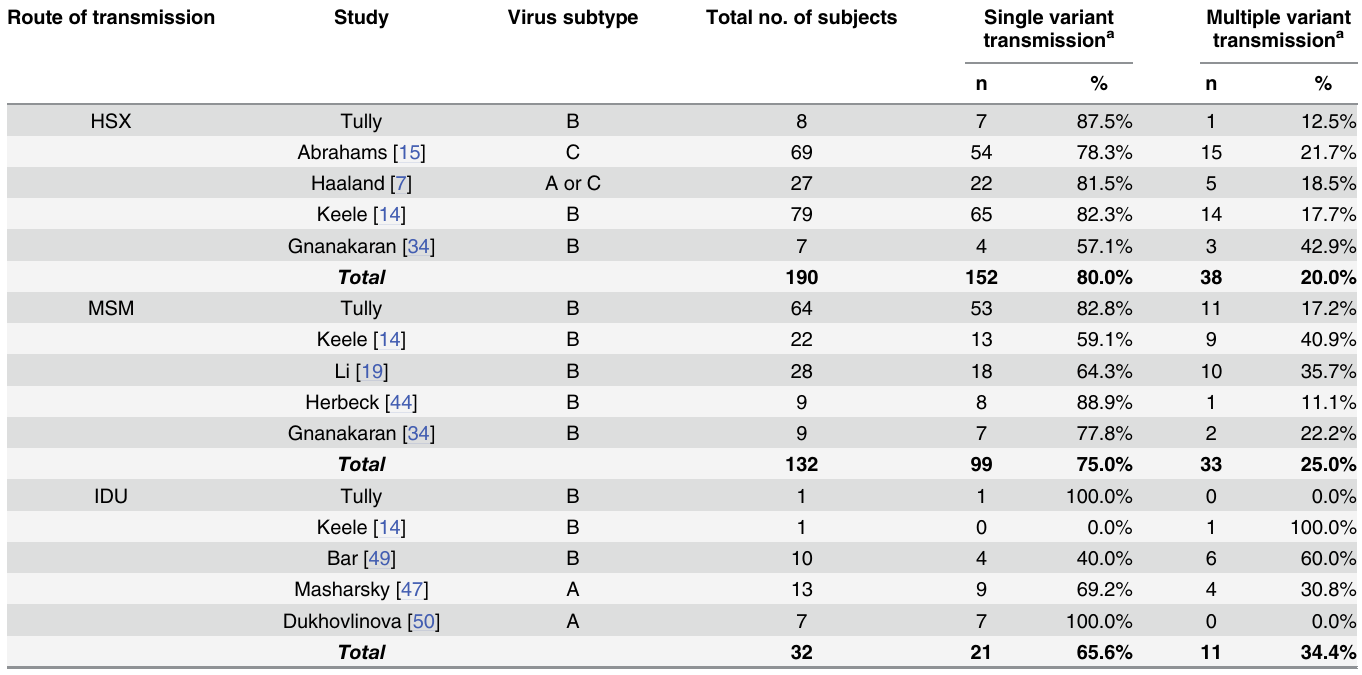
Table 1. Multiplicity of HIV-1 infection in HSX, MSM and IDU subjects. Route of